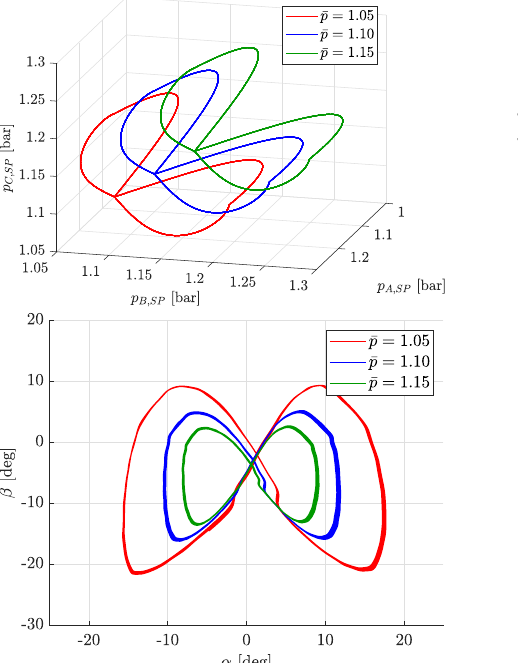
Figure 8. The figure shows a visualization of the control allocation strategy. ( Top left ) The plot shows the pressure setpoints in the absolute representation, ( top right ) the virtual control inputs and ( bottom ) the resulting angular trajectories. Each of the three trajectories has a constant lower pressure level that increases from the red curve ( ¯ p = 1.05bar) to the blue curve ¯ p = 1.10bar and to the green curve ( ¯ p = 1.15bar). The setpoint trajectory for the virtual control inputs defines a figure-eight trajectory with a different vertical offset corresponding to different lower pressure levels that result in figure-eight trajectories in the angular space of varying magnitude. Each of the three virtual control input trajectories has the same magnitude, but results in a decreasing angular magnitude for higher values of ¯ p . The reason for this behavior is that the movable link is forced towards a straight orientation wrt. the static link for increasing values of ¯ p leading to a decrease in angular magnitude. While the set point trajectories have a simple form in the virtual control input representation, the resulting absolute pressure setpoints are rather complex, emphasizing the importance of the control allocation